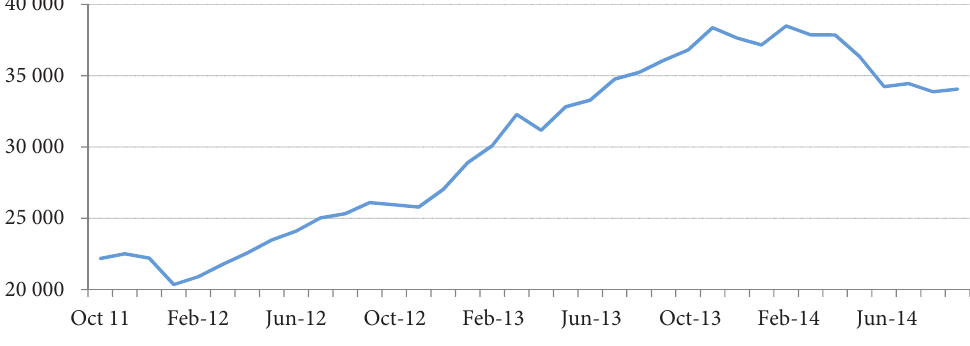
2014Figure A1. Mean average PSM for each month from Oct 2011 to Sep 2014